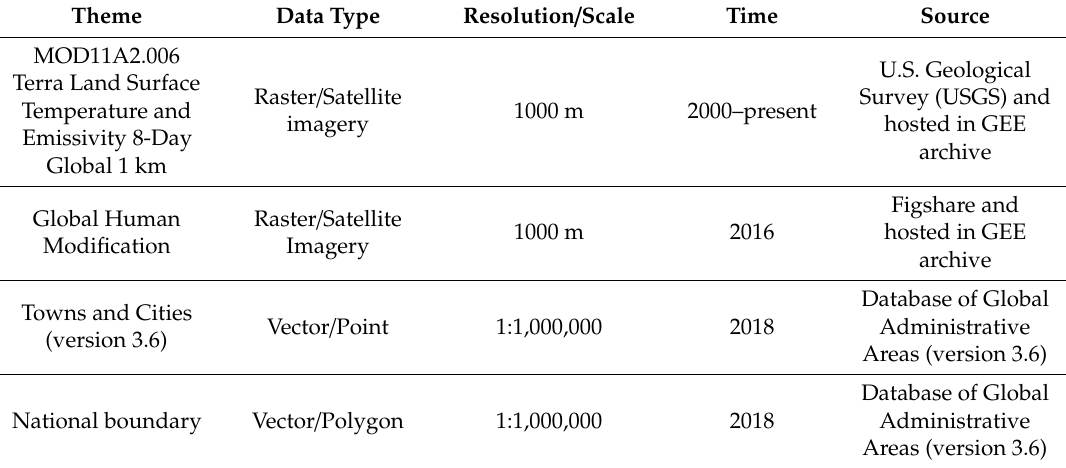
Table 1. Overview of the main datasets.